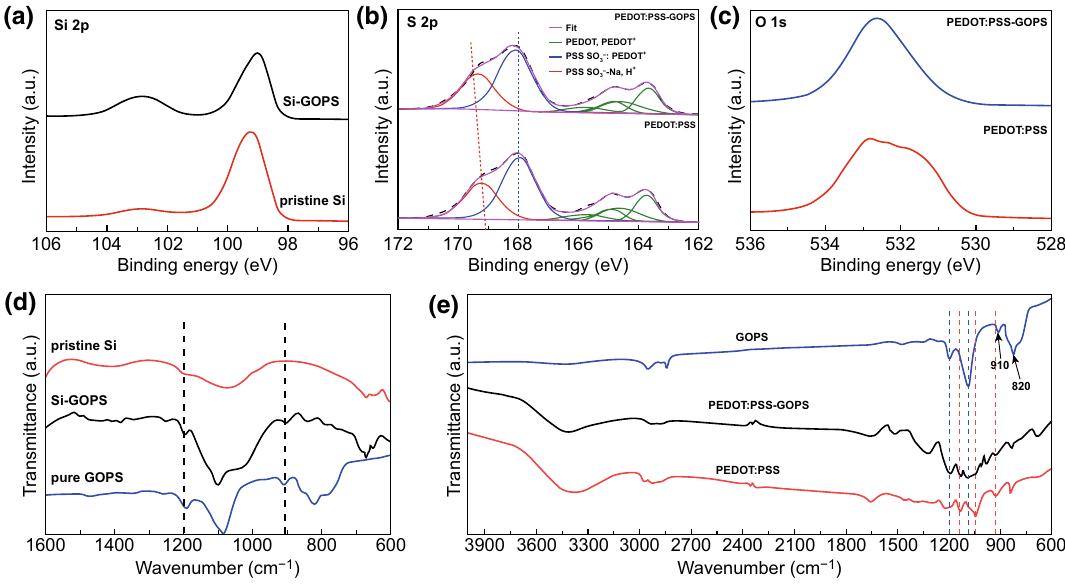
Fig. 2 XPS analysis: a Si 2p region of raw Si and after treatment by GOPS; b, c S 2p and O 1s spectrum of pure PEDOT:PSS and after treat- ment by GOPS. FTIR measurements of d raw Si NPs, pure GOPS, and Si after treatment with GOPS; e pure PEDOT:PSS, pure GOPS, and PEDOT:PSS after treatment by